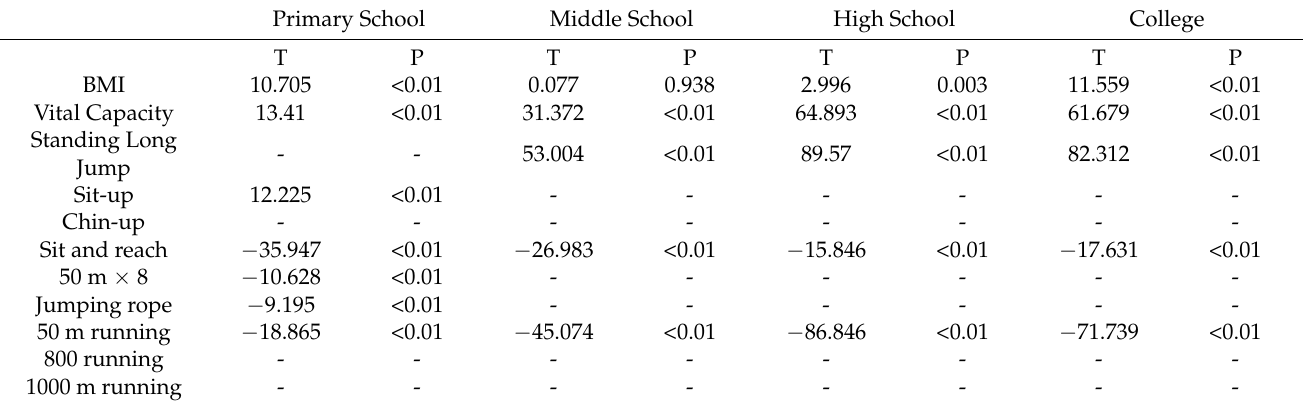
Table 4. The difference in the performance of physical fitness in gender (male = 12,094, female = 15,087).